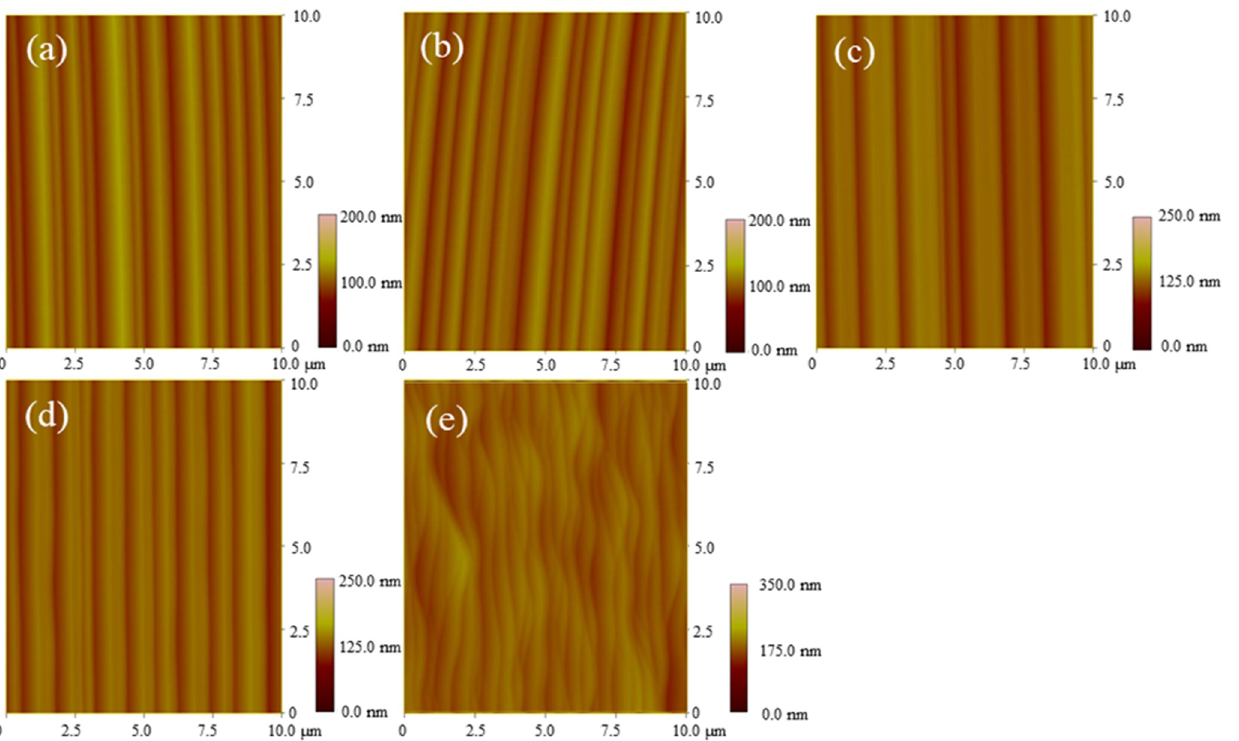
Figure 5. AFM images of 4H-SiC epitaxial wafers with C/Si ratios of ( a ) 0.6, ( b ) 1.0, ( c ) 1.2, ( d ) 1.5, and ( e ) 2.0.